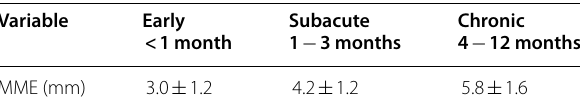
Table 2 Three groups of patients according to the onset and MME measurement of